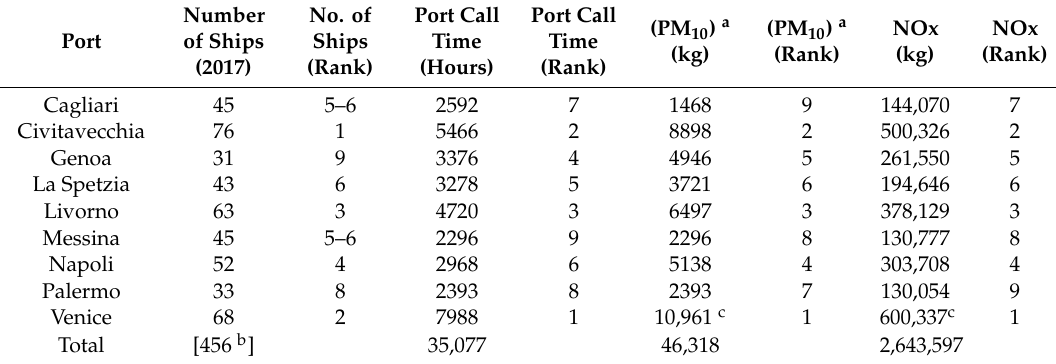
Table 4. Cruise Ship